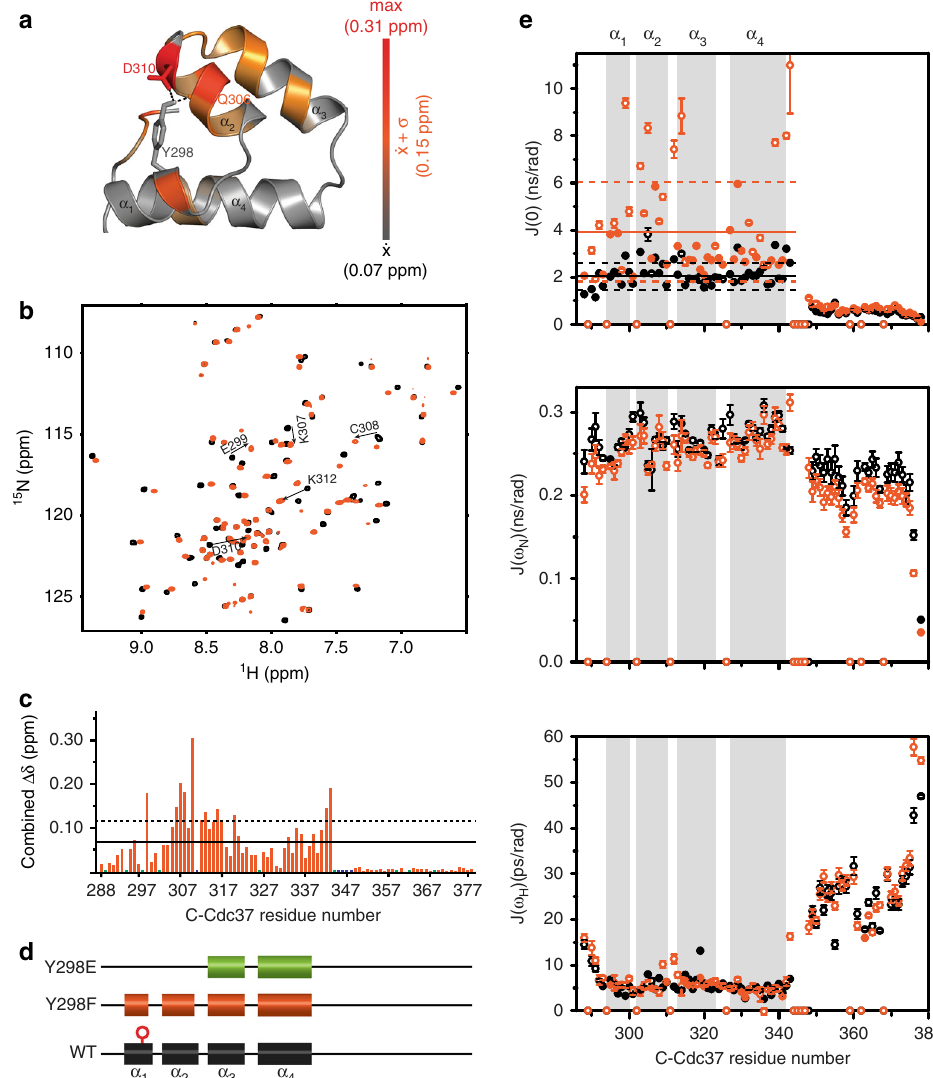
Fig. 1 Conformational properties of C-Cdc37 Y298F . a The hydrogen-bond network of Y298 involving Q306 and D310 is shown as black dashed lines on the solution structure of C-Cdc37. C-Cdc37 is colored with a gray-to-red gradient, according to the observed chemical shift perturbation between the wild-type and Y298F C-Cdc37. b Overlay of the 15 N-HSQC of Y298F (orange) and wild-type C-Cdc37 (black) with the tryptophan indole region omitted. c Magnitude of CSP between wild-type and C-Cdc37 Y298F . Prolines are shown as green bars and unassigned residues as blue bars. CSPs higher than the mean or one standard deviation above the mean are marked with solid and dashed lines, respectively. d Chemical shift-derived secondary structure for wild-type (black), Y298F (orange), and Y298E (green) C-Cdc37. e Reduced spectral density functions J (0) (top), J( ω N ) (middle), and J(0.87 ω H ) (bottom) of Y298F (orange) and wild-type Cdc37 (black). Solid and dashed lines mark the mean and the mean ± one standard deviation of the spectral density functions across the C-Cdc37